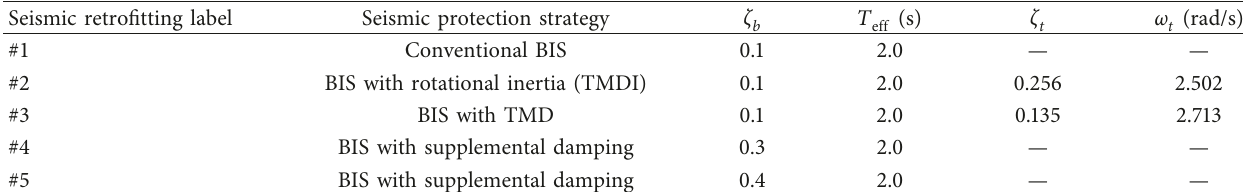
Table 2: Seismic retrofitting strategies analyzed and compared in this study and optimal parameters. Seismic retrofitting